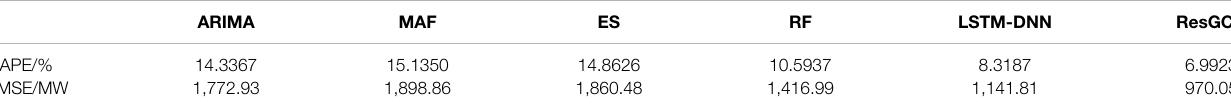
TABLE 2 | Performance metrics of different methods.